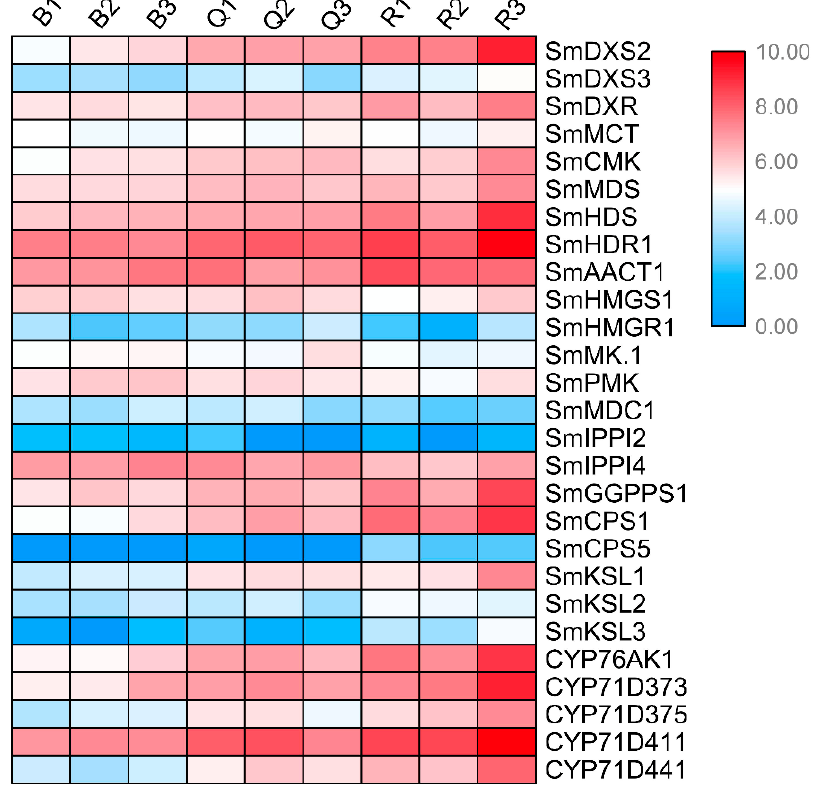
Figure 3. Expression patterns of known genes in tanshinone pathway in three kinds of roots.